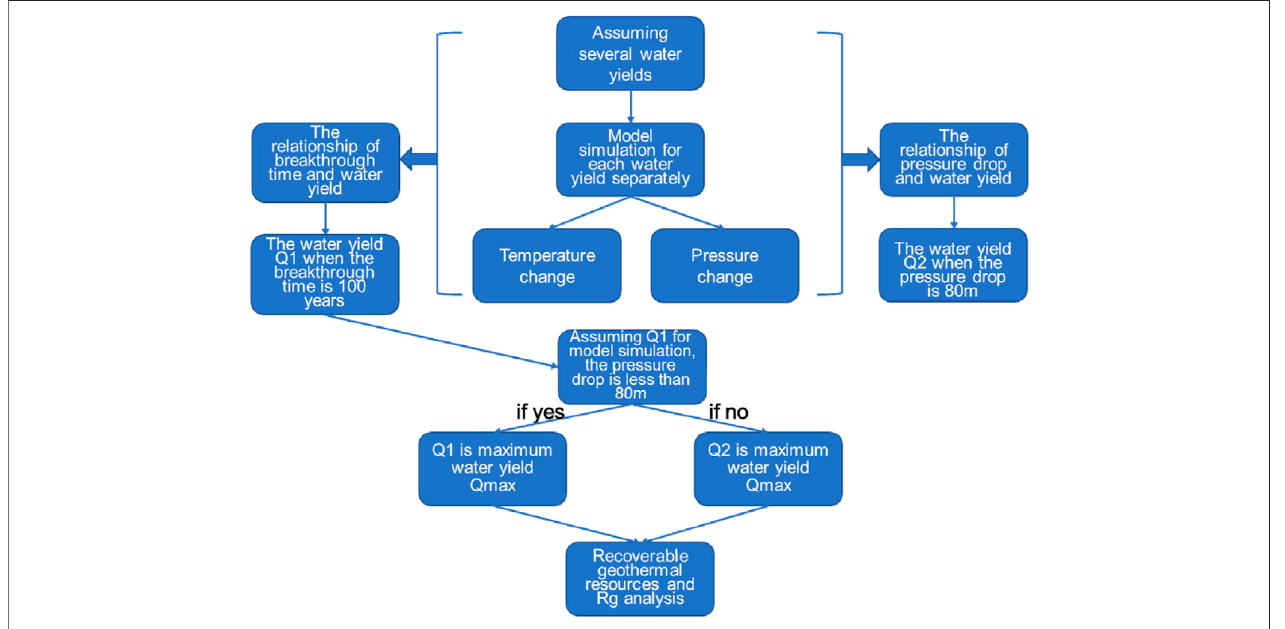
FIGURE 1 | Procedure to acquire the recoverable resources and